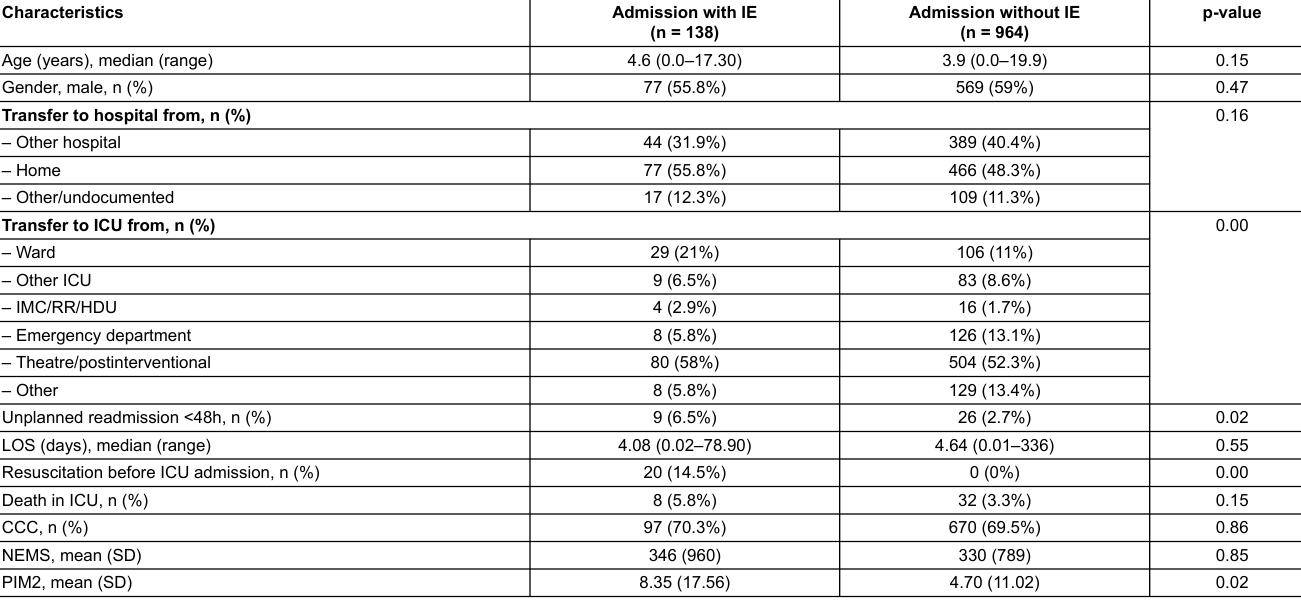
Table 1: Characteristics of admissions to the paediatric intensive care unit with and without an iatrogenic event. Characteristics